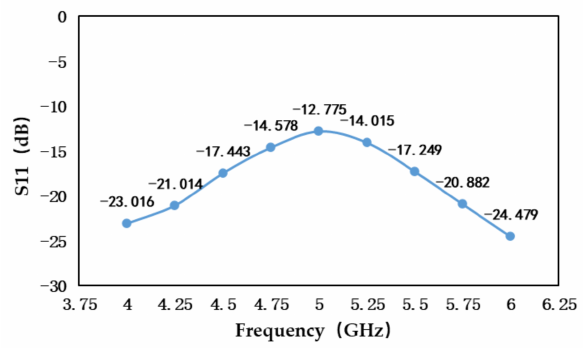
Figure 4. The reflection coefficient of the